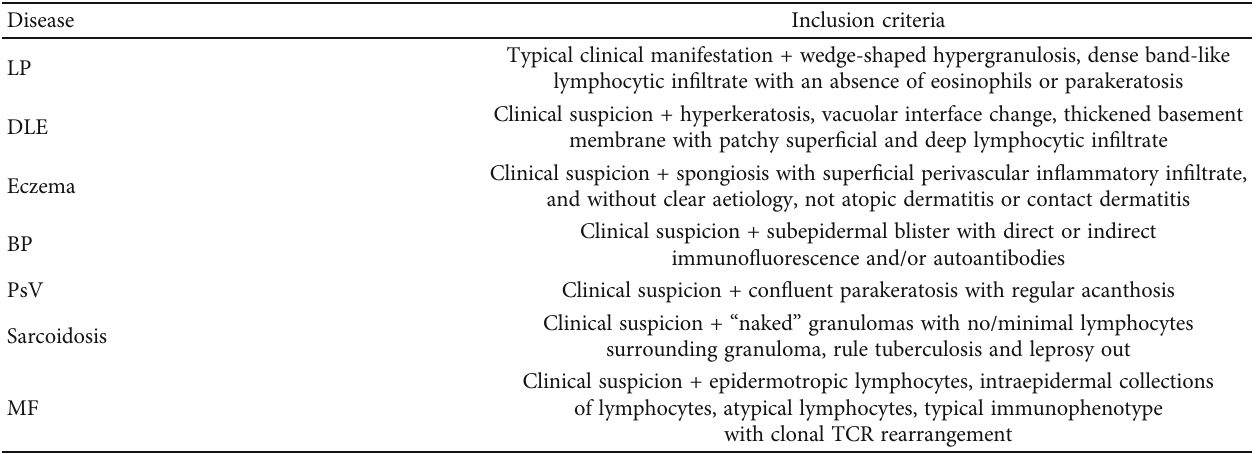
Table 1: Inclusion criteria for specimens used in retrospective analysis.